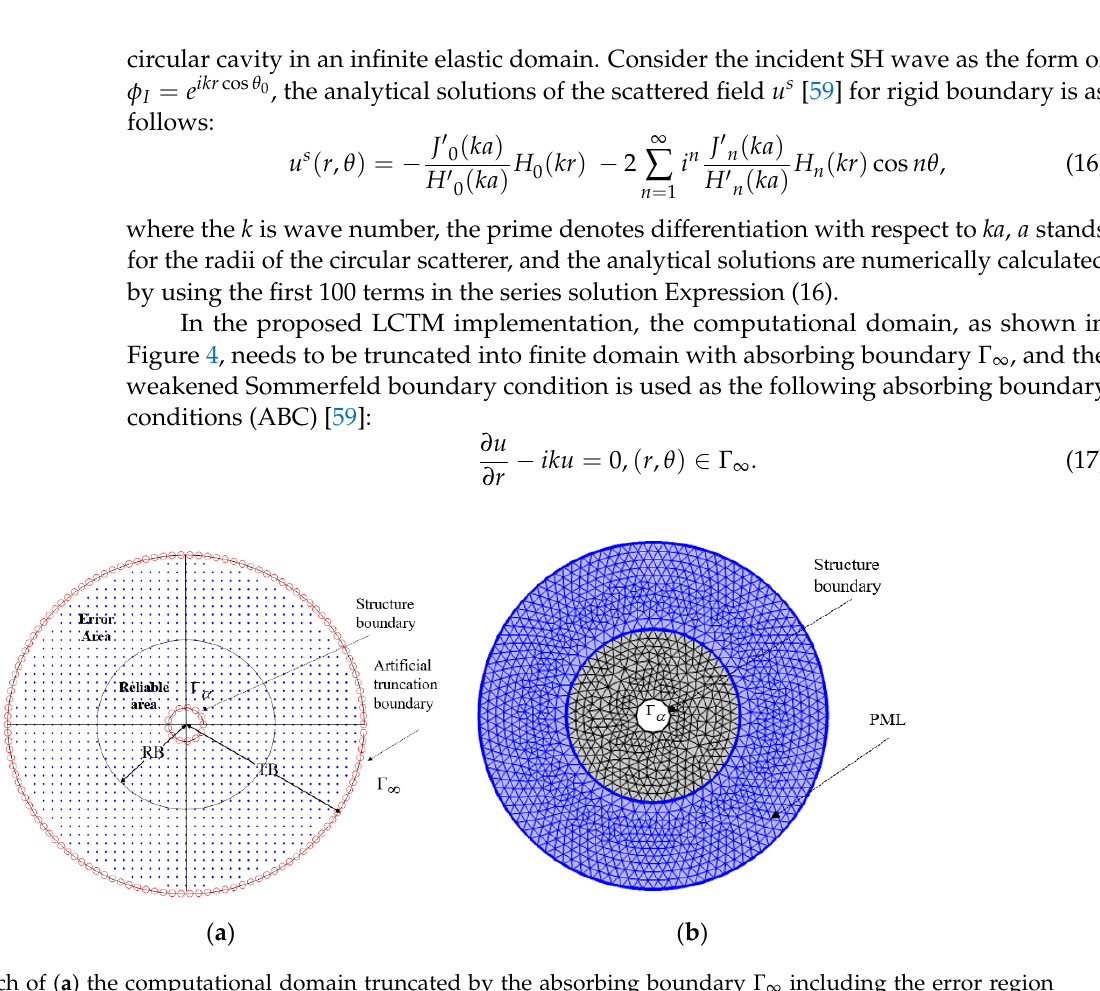
Γ including the error region